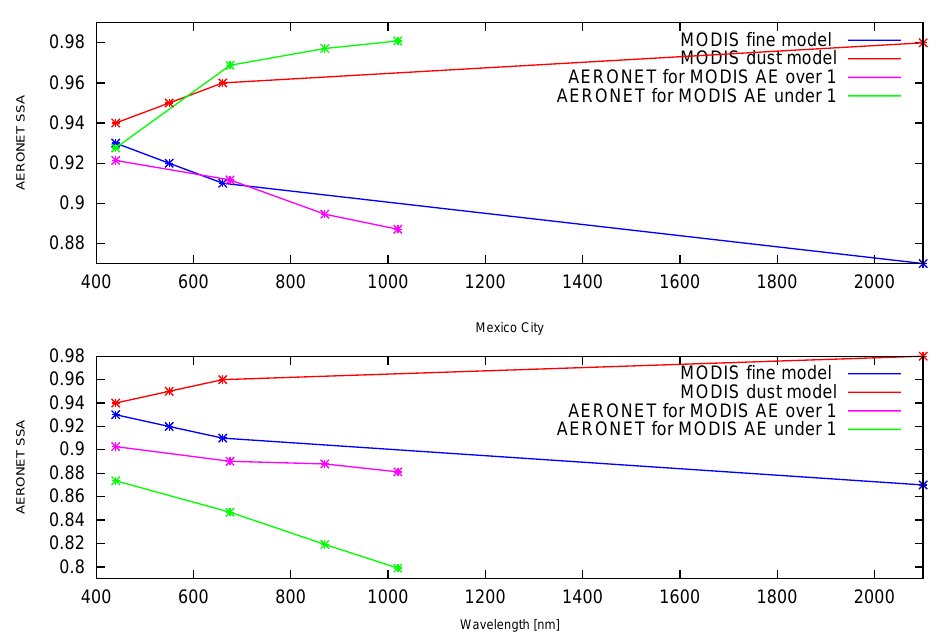
Fig. 3. MODIS aerosol model SSAs compared with AERONET SSA products at two sites: T˜oravere and Mexico City. SSA spectra for a-priori dust and fine models (moderately absorbing) used in MODIS retrieval are shown in red and blue, respectively. The magenta line represents the averaged SSA spectrum from AERONET measurements for observations whose MODIS AE is over 1 (fine model). The green color is an average for observations whose MODIS AE is smaller than 1 (dust model). At T˜oravere the dust measurements are from a single dust episode (22 March 2007). Only measurements with AOD(550nm) values larger than 0.3 (MODIS and AERONET) are considered.